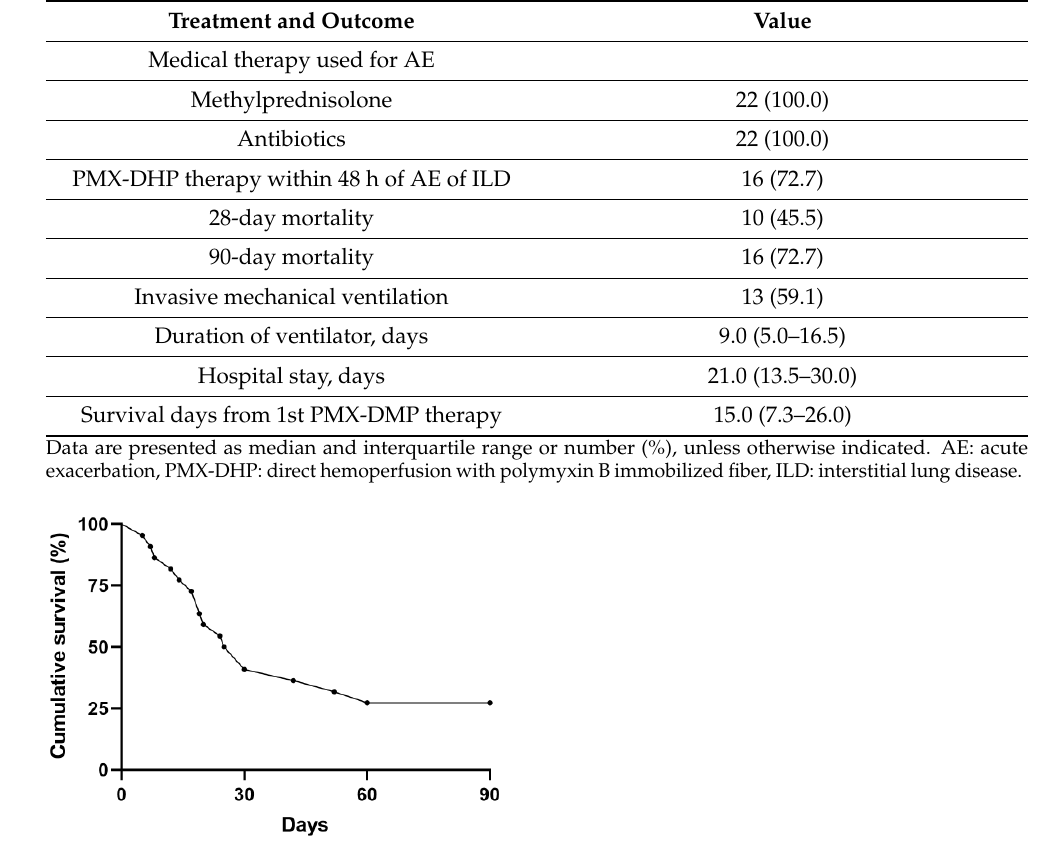
Figure 1. Kaplan–Meier survival curve for patients with acute exacerbation of interstitial lung disease treated with polymyxin B-immobilized fiber column (PMX-DHP). Among patients treated with PMX-DHP, the 28-day mortality rate was 45.5% and the 90-day mortality rate was 72.7%. Table 2. Treatment and outcome of the patients.